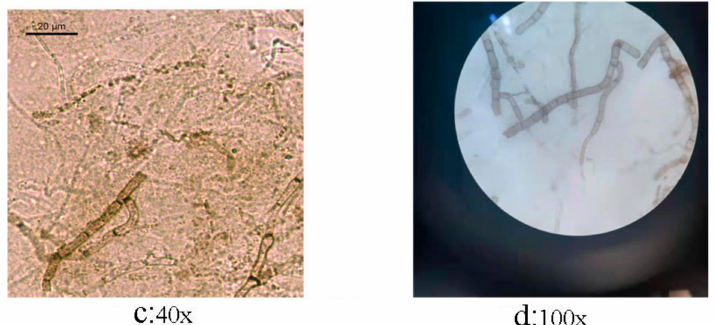
Figure 1. Colony and mycelium morphology of C. beticola . ( a ) The front morphology of the colony of C. beticola . ( b ) The back morphology of the colony of C. beticola . ( c ) Mycelial morphology of C. beticola under 40 × microscope. ( d ) Mycelial morphology of C. beticola under 100 × microscope.